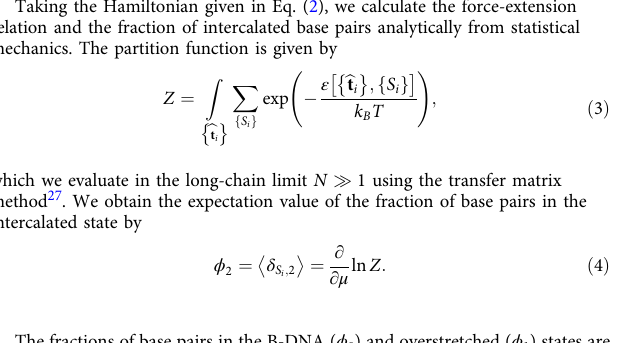
Table 2 Overview of energetic couplings Δ H ( S i , S i +1 ) between neighbouring segments depending on their